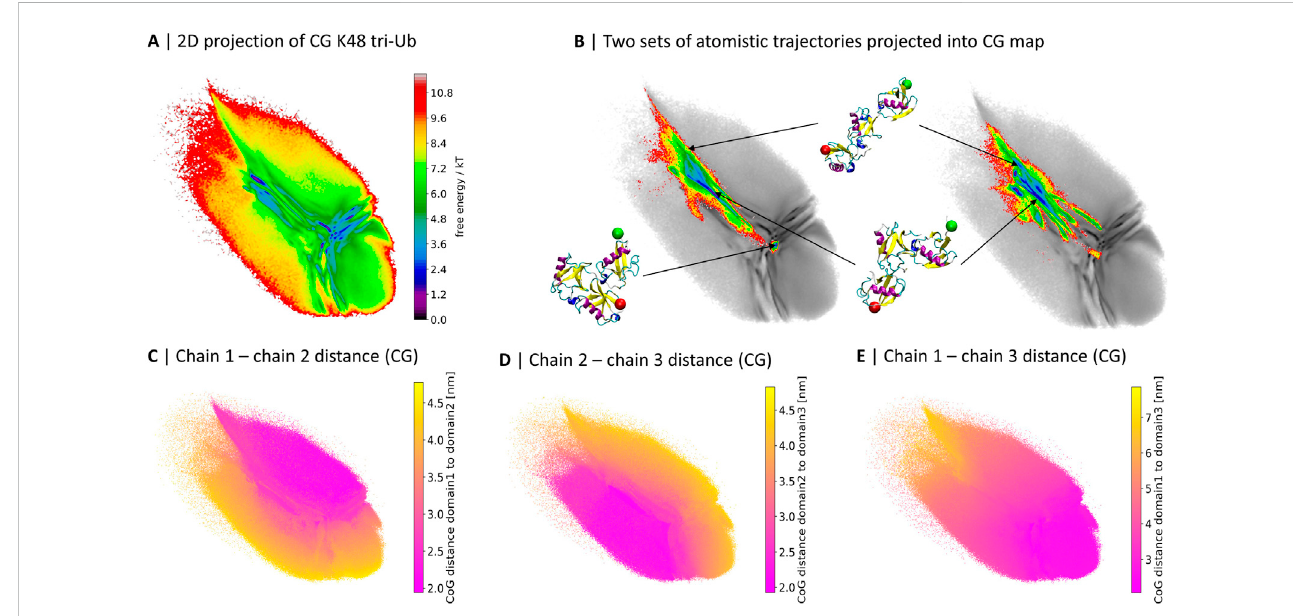
FIGURE 1 2DprojectionsofK48-linkedtri-Ubtrajectoriesfromcoarsegrained(Bergetal.(2020)) (A) andtwoindependentsetsofatomisticsimulations (B) . (B) The atomistic simulations are colored based on free energy values, the CG map is gray and the same as in (A) ; three exemplary conformations from the atomistic simulationsandtheirlocationinthemapareillustrated.Aredsphereisattachedtothe fi rstresidue,indicatingtheproximalunit,andagreensphereisattached tothelastresidue,indicating thedistalmoiety. (C – E) 2Dmapcoloredbythecenterofgeometry(CoG)distancebetweentwoofthethreeUbmoietiesin the CG